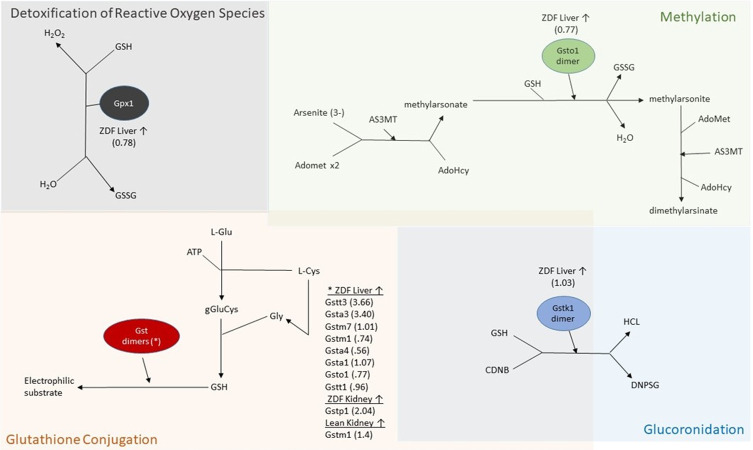
Differentially expressed genes involved in glutathione metabolism.This figure was adapted from D’Eustachio, P., and Jassal, B. from the Reactome [39]. Glutathione metabolism reactions can be categorized into glutathione conjugation, glucuronidation, methylation, or detoxification of reactive oxygen species. All genes are listed within each reaction category followed by their corresponding log2fold change in parentheses for each given tissue. Abbreviations used: ZDF, Zucker Diabetic fatty rat; GSSG, glutathione disulfide; GSH, glutathione; AS3MT, arsenite 3-methyltransferase; AdoMet, S-adenosyl methionine; AdoHcy, S-adenosyl homocysteine; CDNB, 1-chloro-2, 4-dinitrobenzene; DNPSG, S-(2,4-dinitrophenyl)glutathione; glu, glutamate; cys, cysteine; gly, glycine; gGluCys, gamma-glutamyl-L-cysteine; GST, glutathione s-transferase; and GPX, glutathione peroxidase.